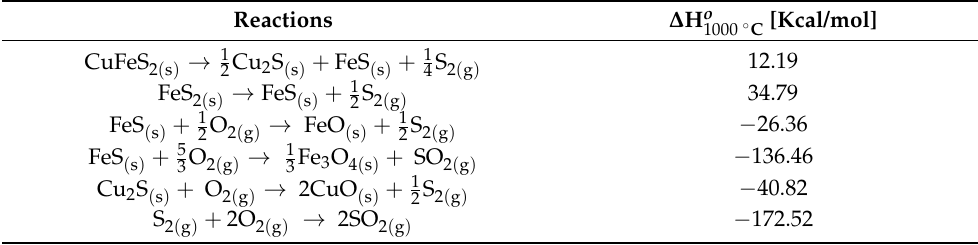
Table 2. Typical reactions during chalcopyrite and pyrite combustion 1